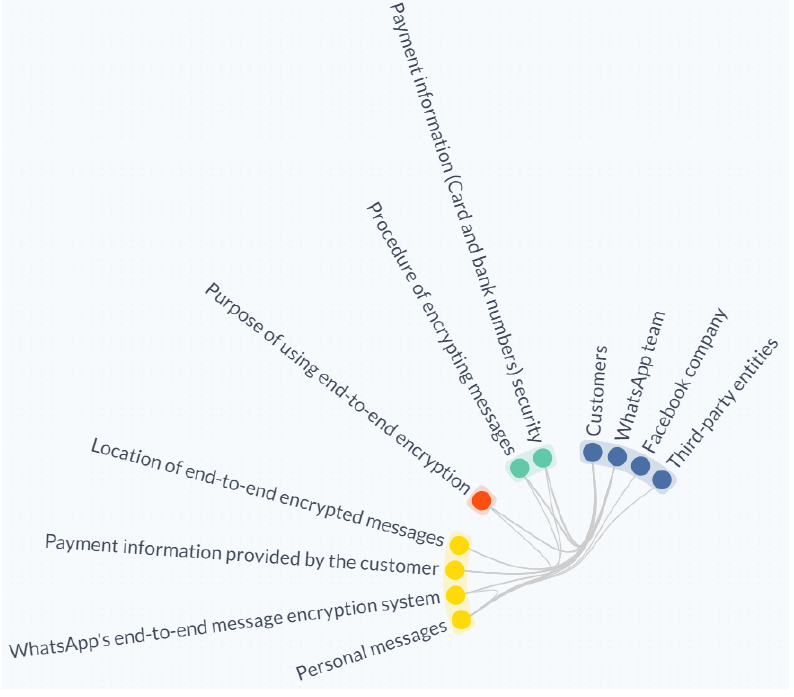
Figure 11. T RANSP V IS : Circle view of WhatsApp keywords.